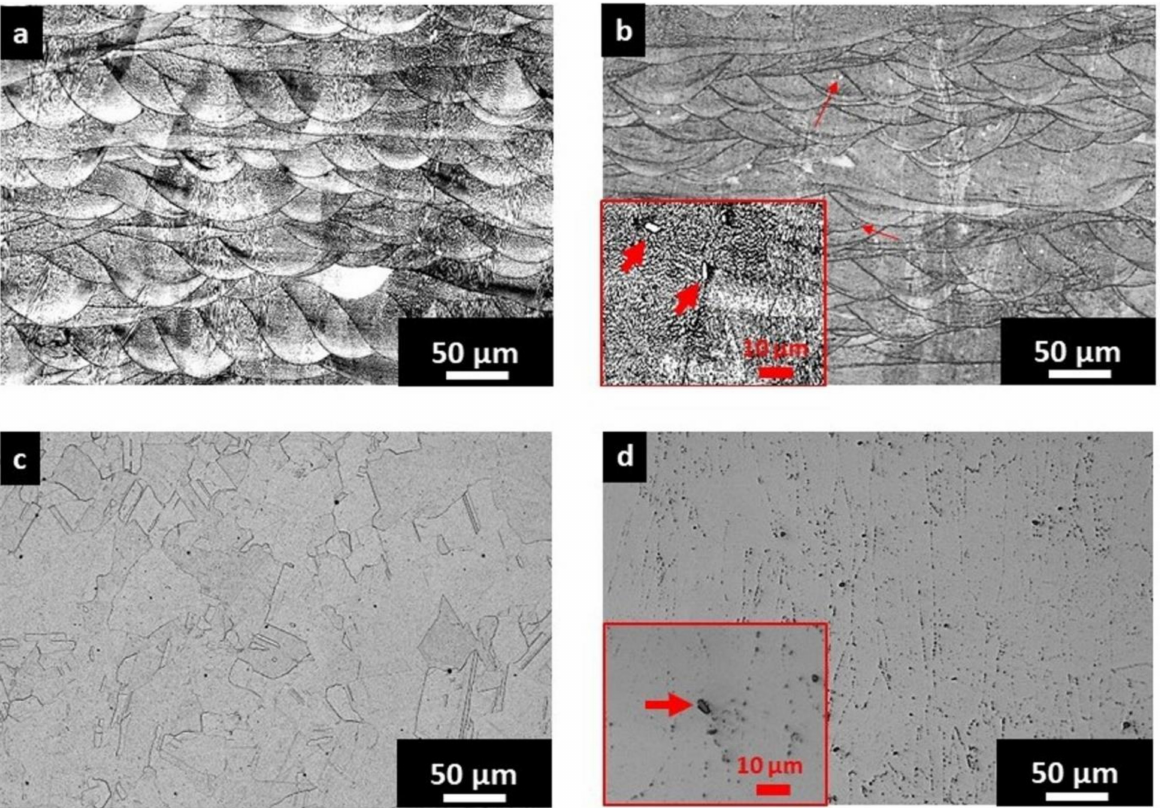
Figure 4. LOM images of: ( a ) AB IN625; ( b ) IN625/TiC; ( c ) SOL IN625; ( d ) SOL IN625/TiC samples etched along the building direction. The red arrows indicate the TiC